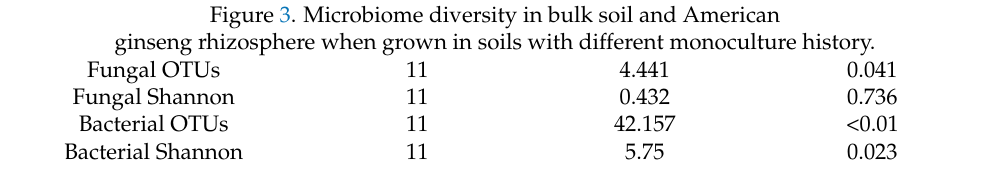
Figure 3. Microbiome diversity in bulk soil and American ginseng rhizosphere when grown in soils with different monoculture history.